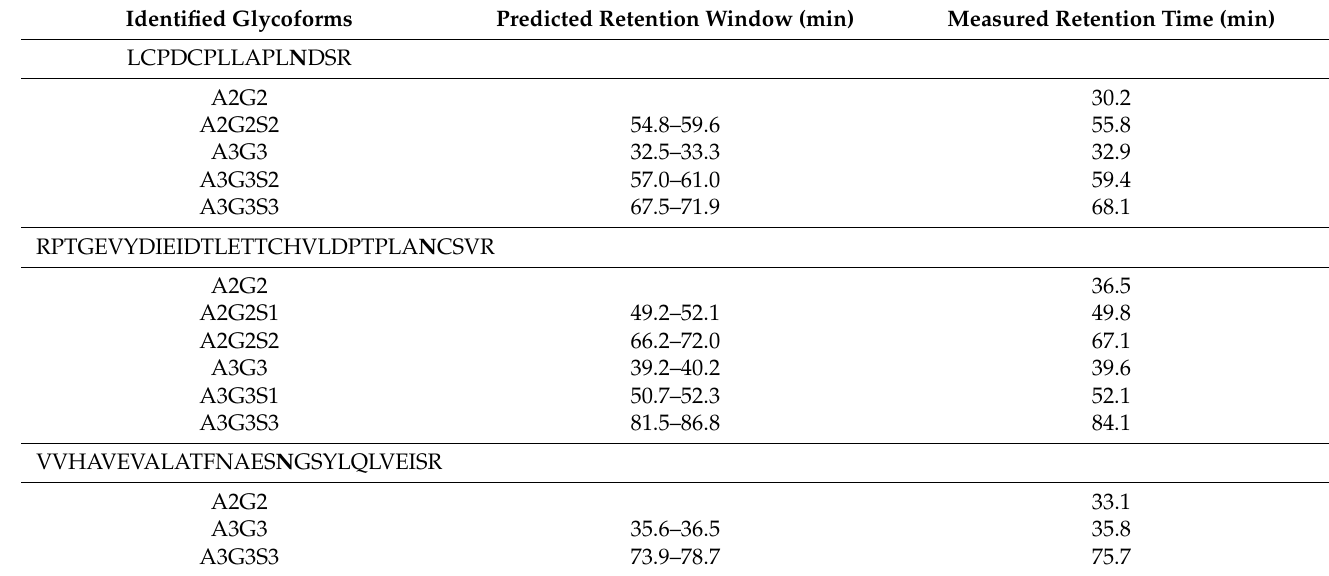
Table 3. Comparison of retention time windows predicted for fetuin glycopeptides with their actual measured retention